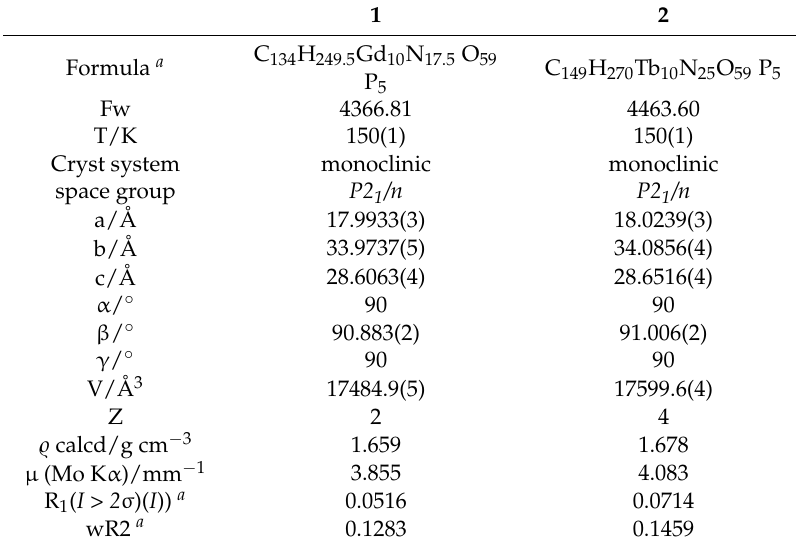
Table 2. Crystallographic information for clusters 1 and